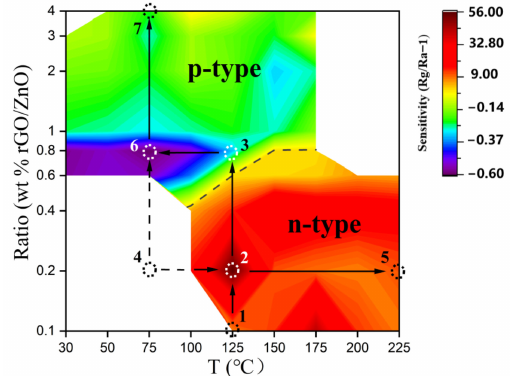
Figure 12. Response of sensors based on the ZnO-x rGO (x = 0.1, 0.2, 0.4, 0.6, 0.8, 1.0, 2.0, 3.0, 4.0) to 4 ppm NO 2 gas at different temperature (30–225 ◦